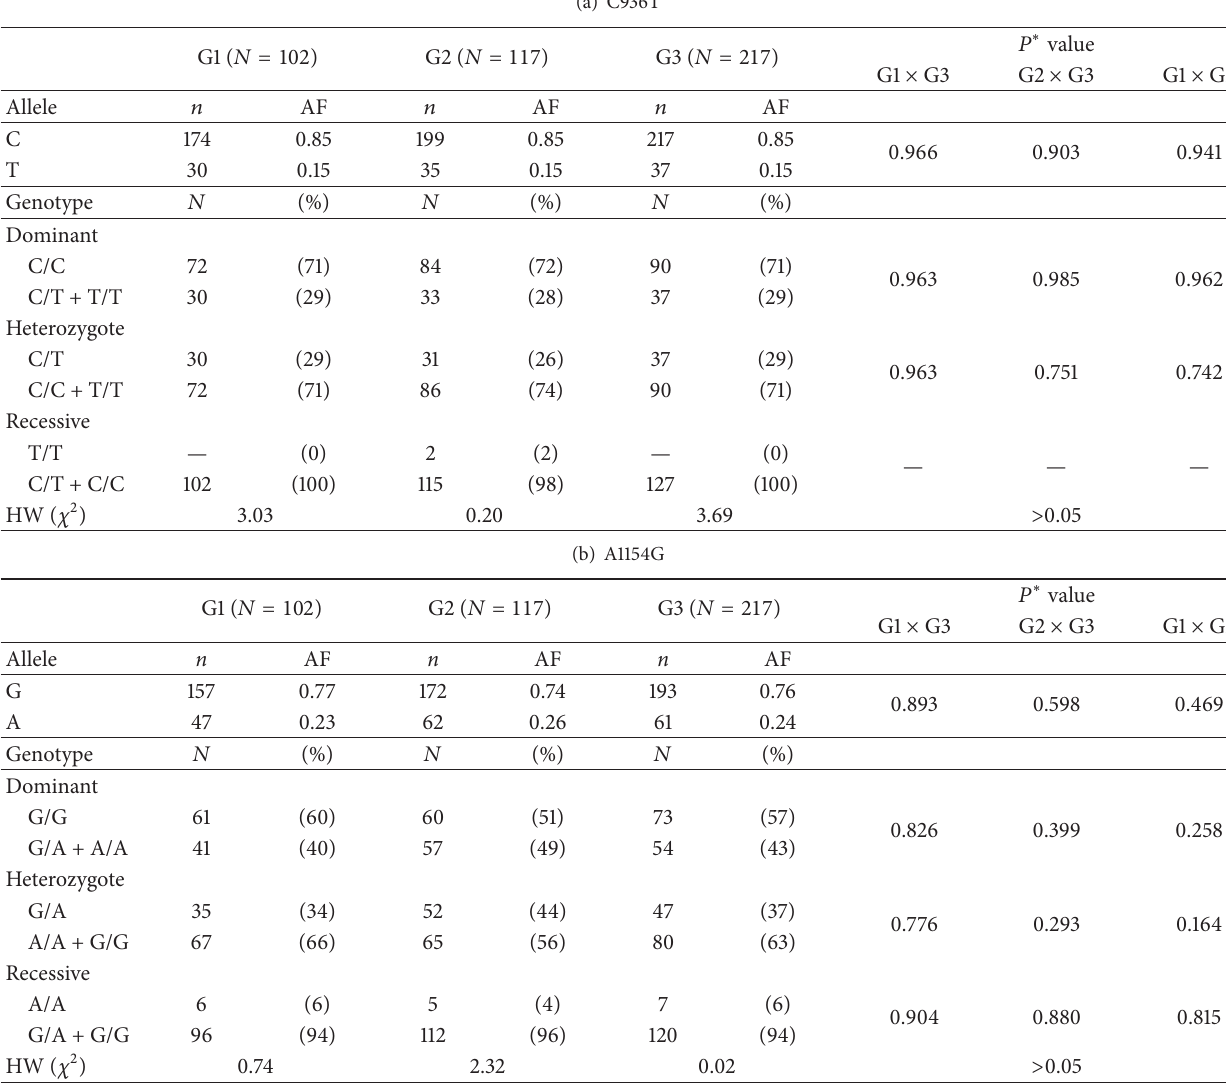
Table 2: Allelic and genotypic frequencies of VEGF -C936T and VEGF -A1154G polymorphisms in patients with hepatocellular carcinoma (G1), cirrhosis (G2), and individuals without the disease